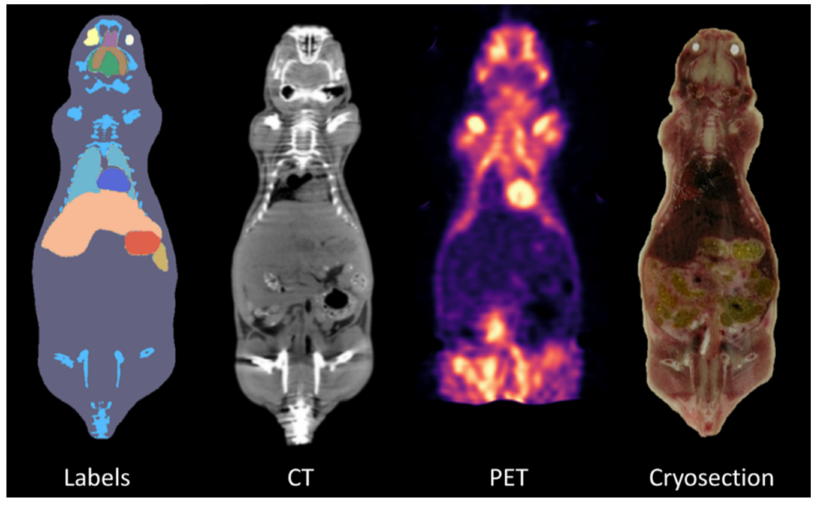
Figure 4. Digimouse Atlas